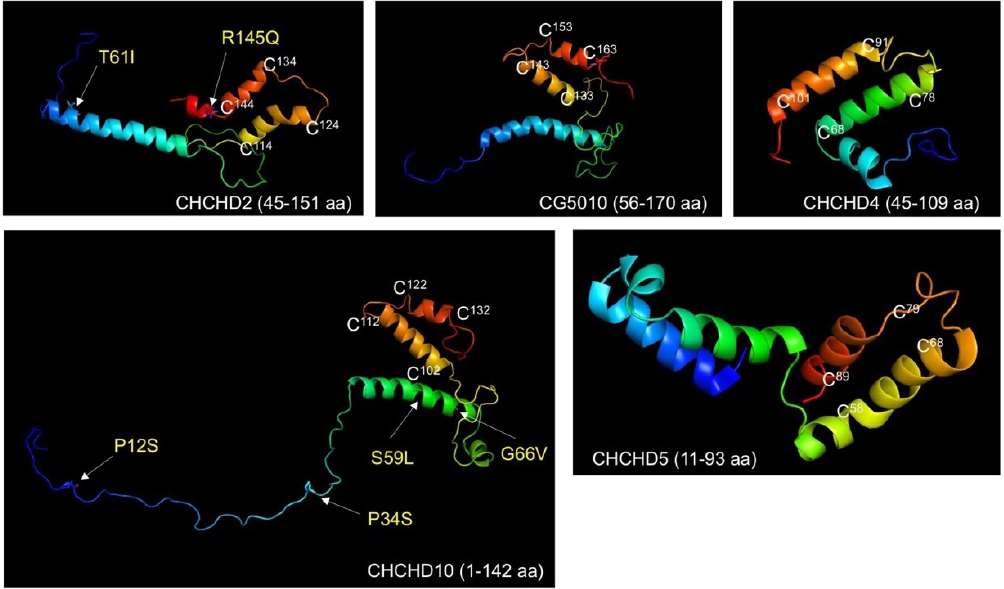
Figure 1. Structures of proteins containing twin CX 9 C motifs. The structures of human CHCHD4/Mia40 and human CHCHD5 were drawn from 2K3J and 2LQL deposited in the protein data bank. The predicted structures of human CHCHD2, human CHCHD10, and Drosophila CG5010 (an orthologue of CHCHD2/10) were depicted using RaptorX structure prediction server. The cold to warm colors indicate N-terminal to C-terminal region. The cysteine residues predicted to form disulfide bonds in twin CX 9 C motifs (white) and key residues associated with pathogenesis (yellow) are also shown. The central α -helices (see also Figure 2) and twin CX 9 C motifs are highly conserved among CHCHD2, CHCHD10, and CG5010, while there are several predicted disorder regions in these proteins, which makes it difficult to draw accurate structures. Note that the predicted structures of CHCHD2, CHCHD10, and CG5010 may not reflect the physiological conformation due to in silico analysis.